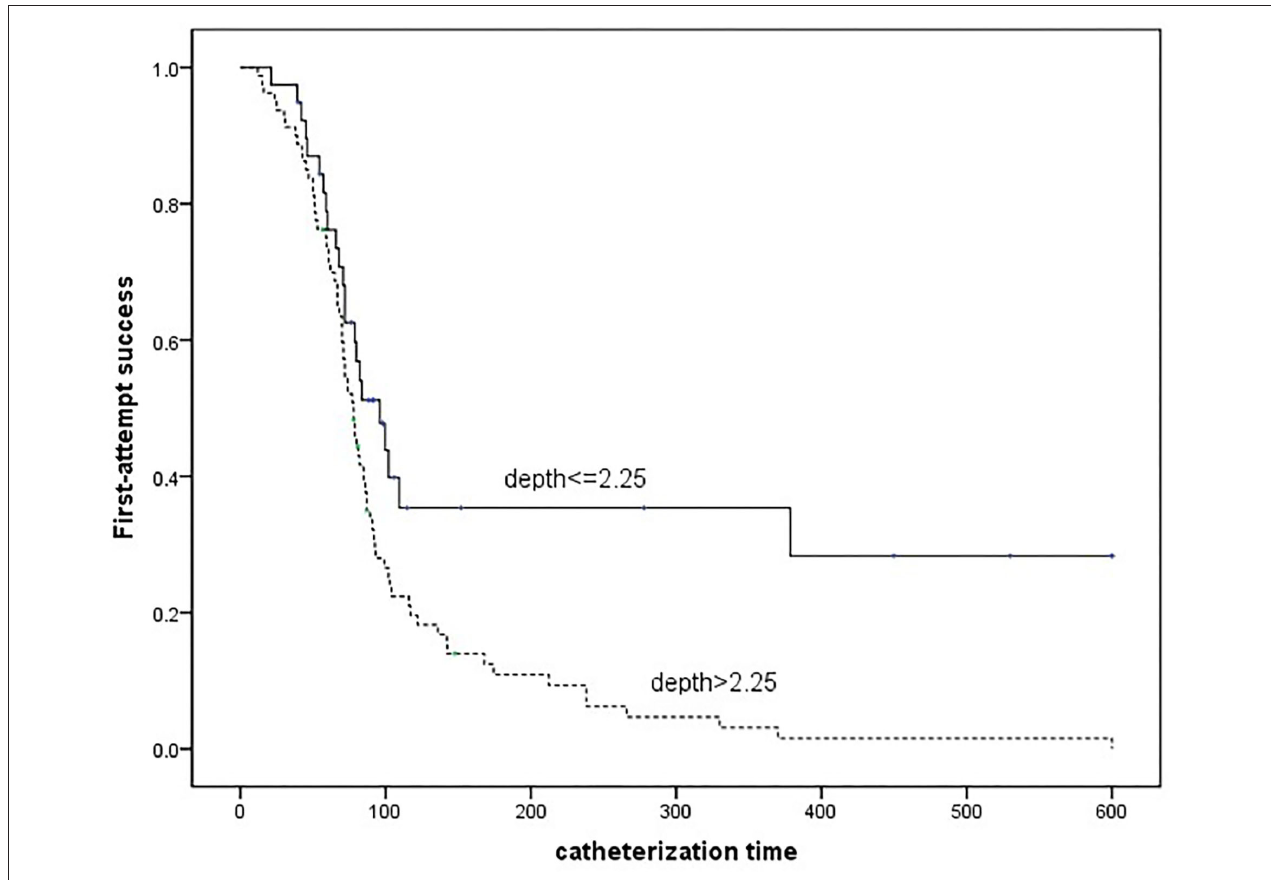
FIGURE 2 | Kaplan-Meier curve estimates the differences of time required for the first-attempt success grouped by the arterial